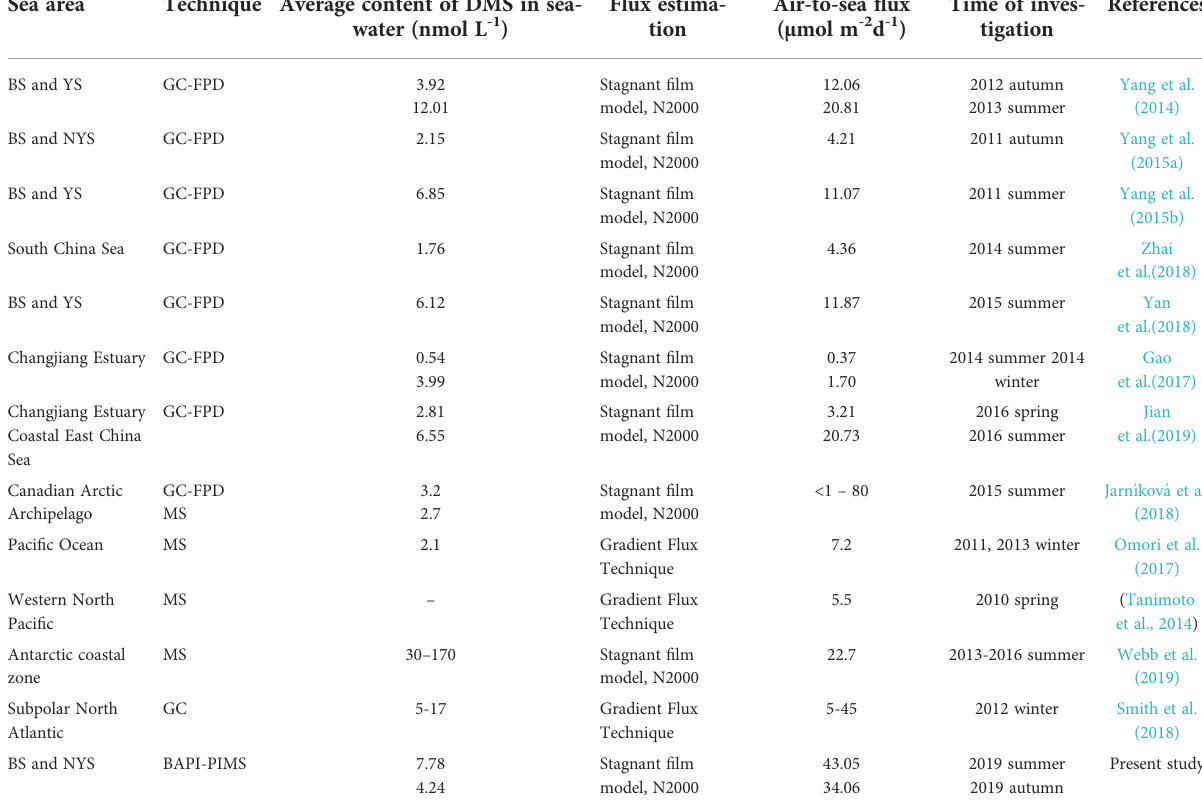
TABLE 1 Air-to-sea fl ux of DMS and corresponding models reported in recent studies. Sea area